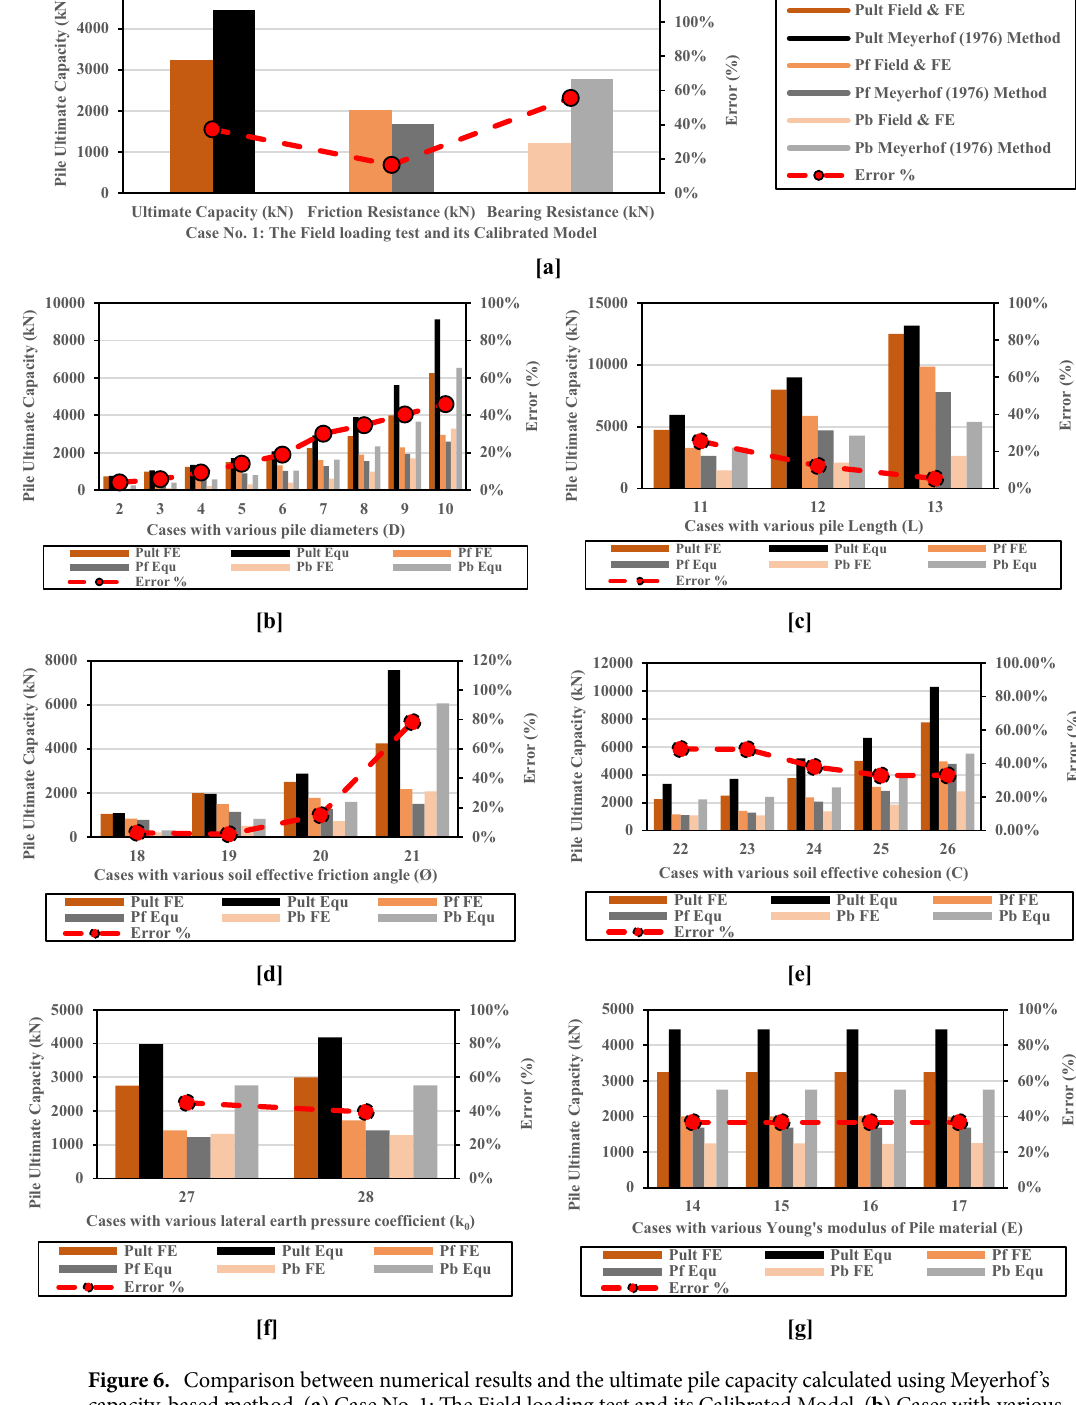
Figure 6. Comparison between numerical results and the ultimate pile capacity calculated using Meyerhof’s capacity-based method. ( a ) Case No. 1: The Field loading test and its Calibrated Model. ( b ) Cases with various pile diameters (D) ( c ) Cases with various pile Length (L) ( d ) Cases with various soil effective friction angle (Ø) ( e ) Cases with various soil effective cohesion (C) ( f ) Cases with various lateral earth pressure coefficient (k 0 ) ( g ) Cases with various Young’s modulus of Pile material